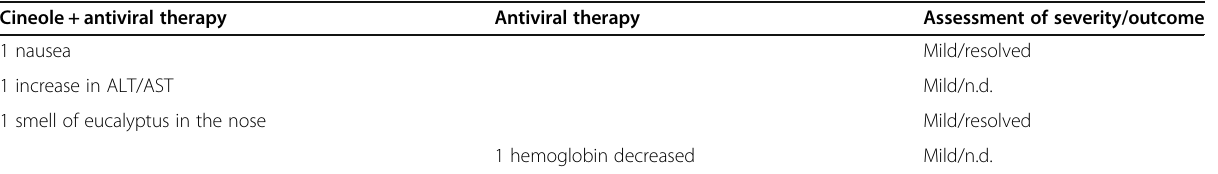
Table 3 Adverse events during the study Cineole + antiviral